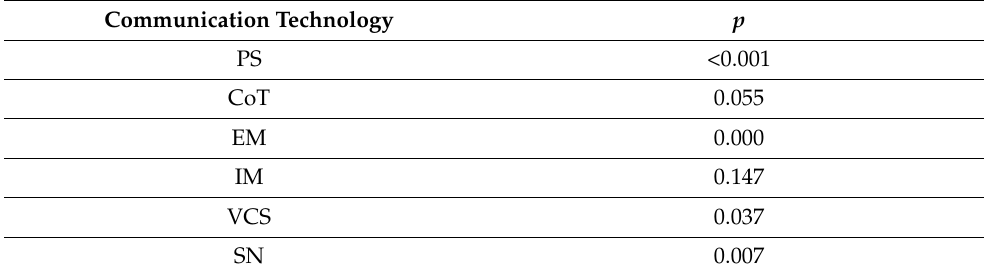
Table 24. Results of statistical inference t-test to verify the independence of the responses of students and teachers to question 11 about the confirmation of expectations on the use of communication technologies ( p ≤